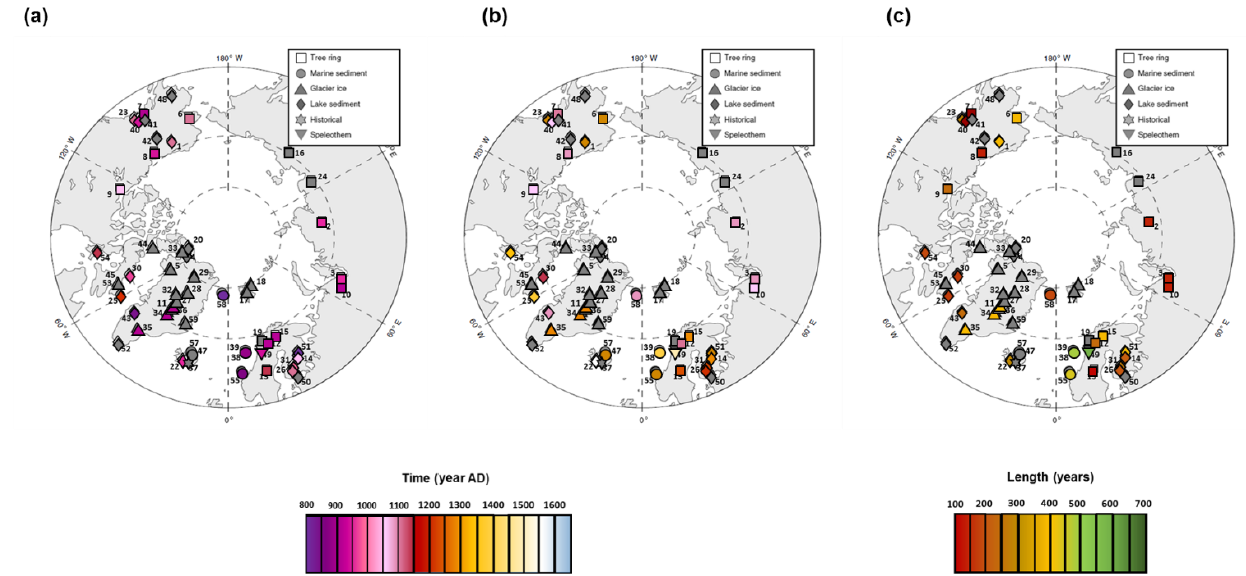
Figure 6. Expression of the Medieval Climate Anomaly (MCA) of the Arctic 2k series based on a reference paper (see McKay and Kaufman, 2014): starting (a) , ending (b) and length (c) . Symbols in grey correspond to series for which the MCA is not mentioned by the authors. More details concerning the temporal expression of the LIA are available in Table S4 and Fig. S2.